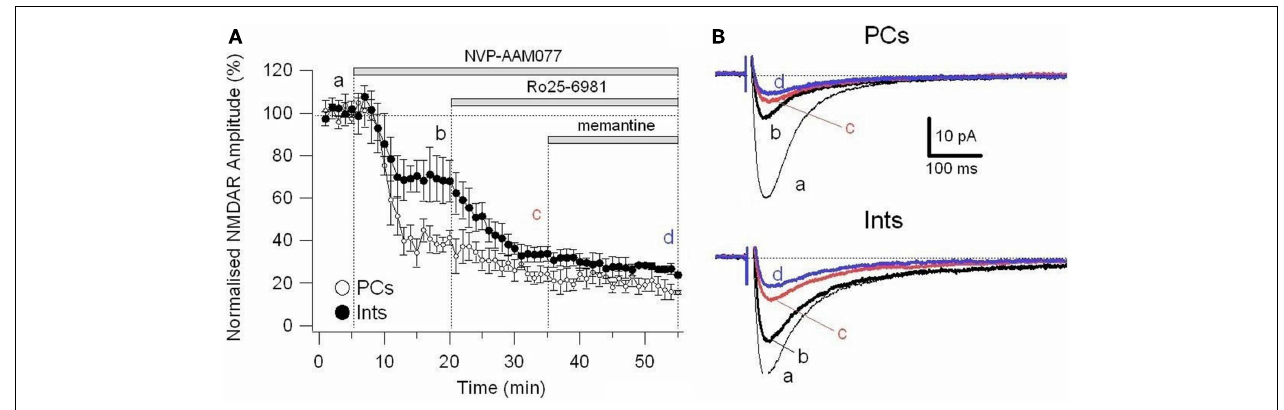
circle) and Ints (full circle). Normalized NMDAR current amplitudes (%) are plotted as a function of time. Each point (one every min) is the average of 6 points (stimulation every 10s).The bars indicate the duration of drug application. (B) Examples of traces of NMDAR currents recoded in PCs (top) and Ints (bottom). Each trace is an average of 30